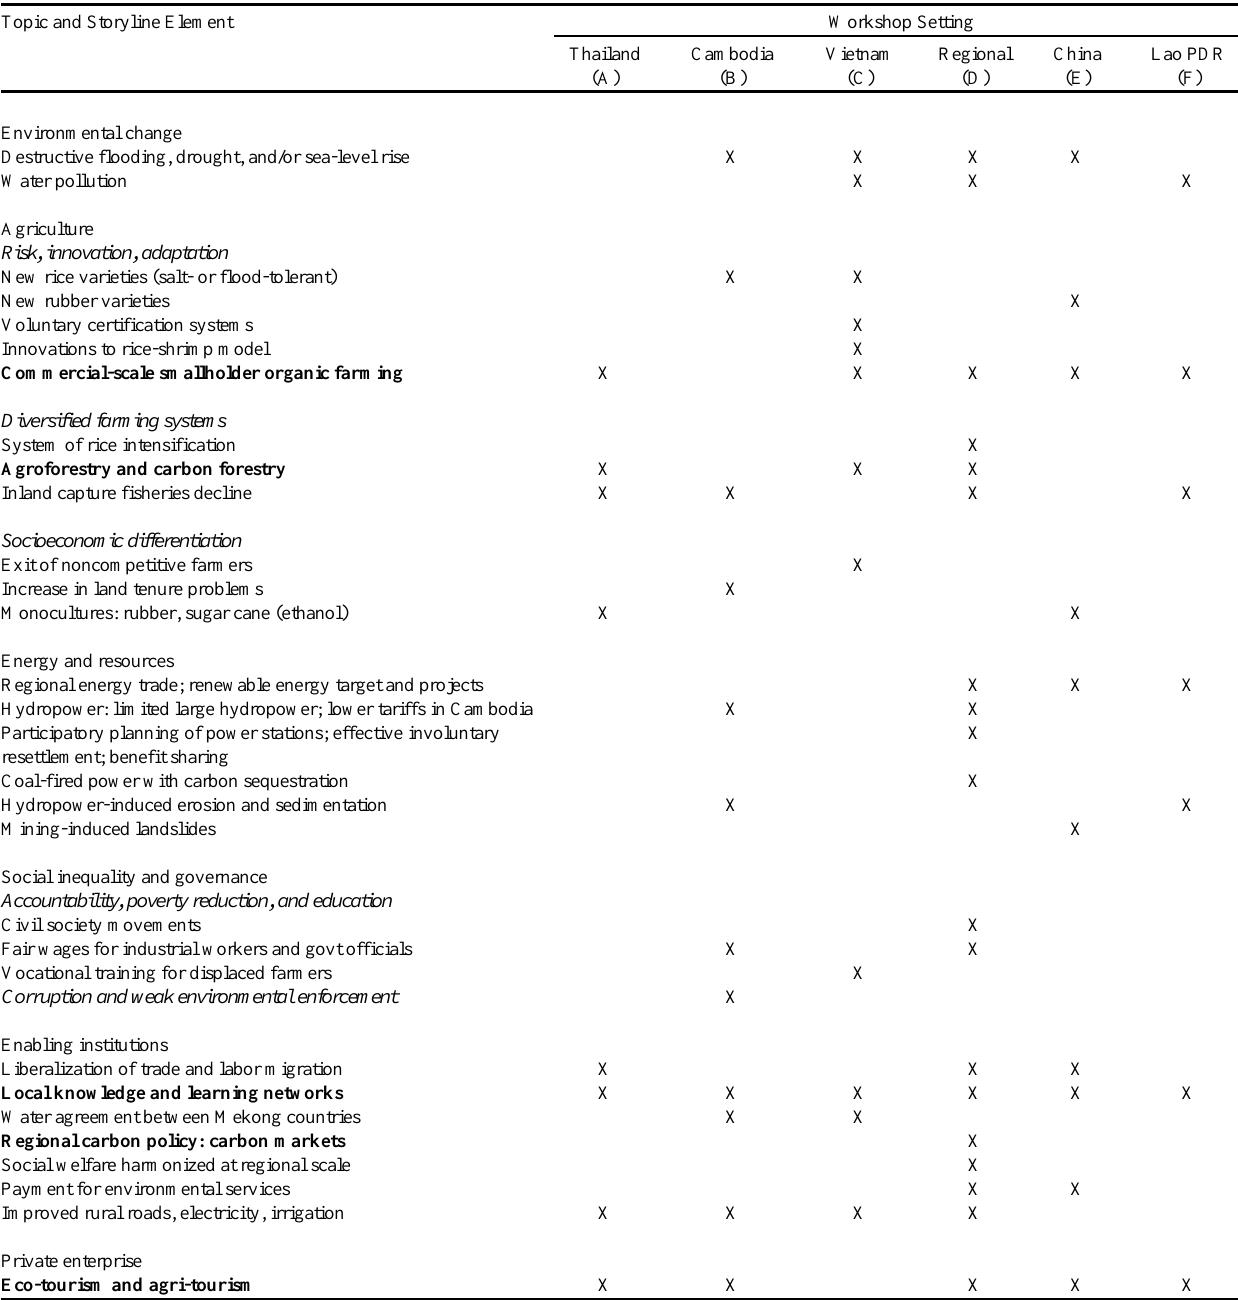
Table 4 . Summary of scenario topics and storyline elements. Notes: “X” means item occurs in one or more narratives in given setting. Italicized headings denote themes and bold items refer to traceable cross-scale storyline elements (see text). Topic and Storyline